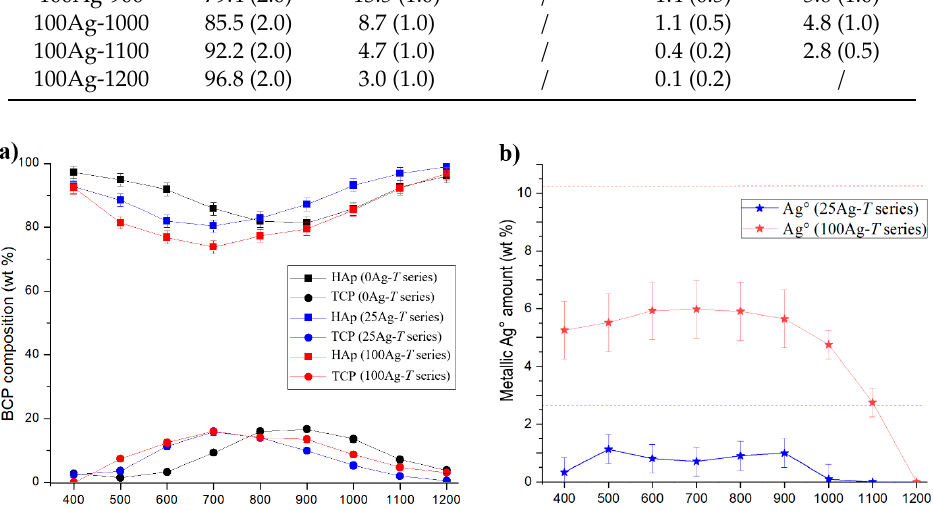
Figure 1. Powder X-ray diffraction ( P XRD) patterns from the 25Ag- T series. Scattering signals are mainly those from the hydroxyapatite (HAp) phase, and other phases are identified thanks to their intense diffraction peaks (*: Ag°, #: CaO, ¤: CaCO 3 , and $: tricalcium phosphate ( β -TCP)).